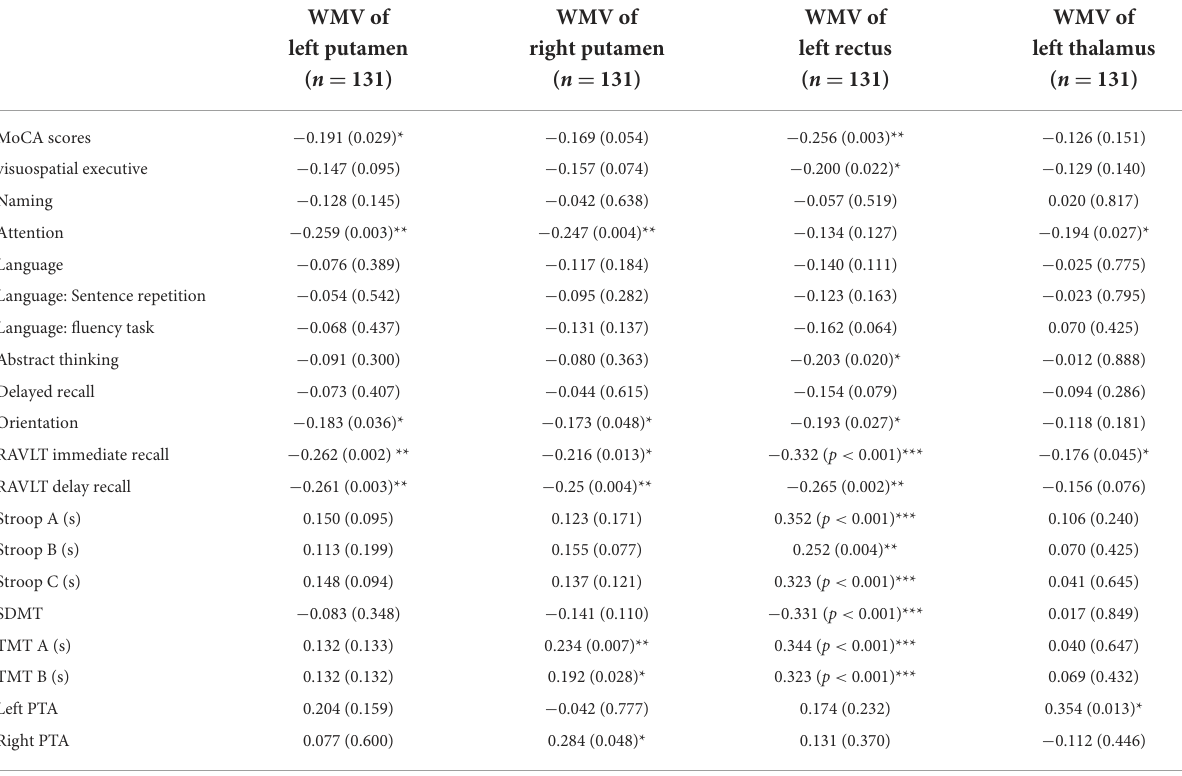
TABLE 5 Results of the analysis of the correlation between differential white matter volume and cognitive and clinical information. WMV